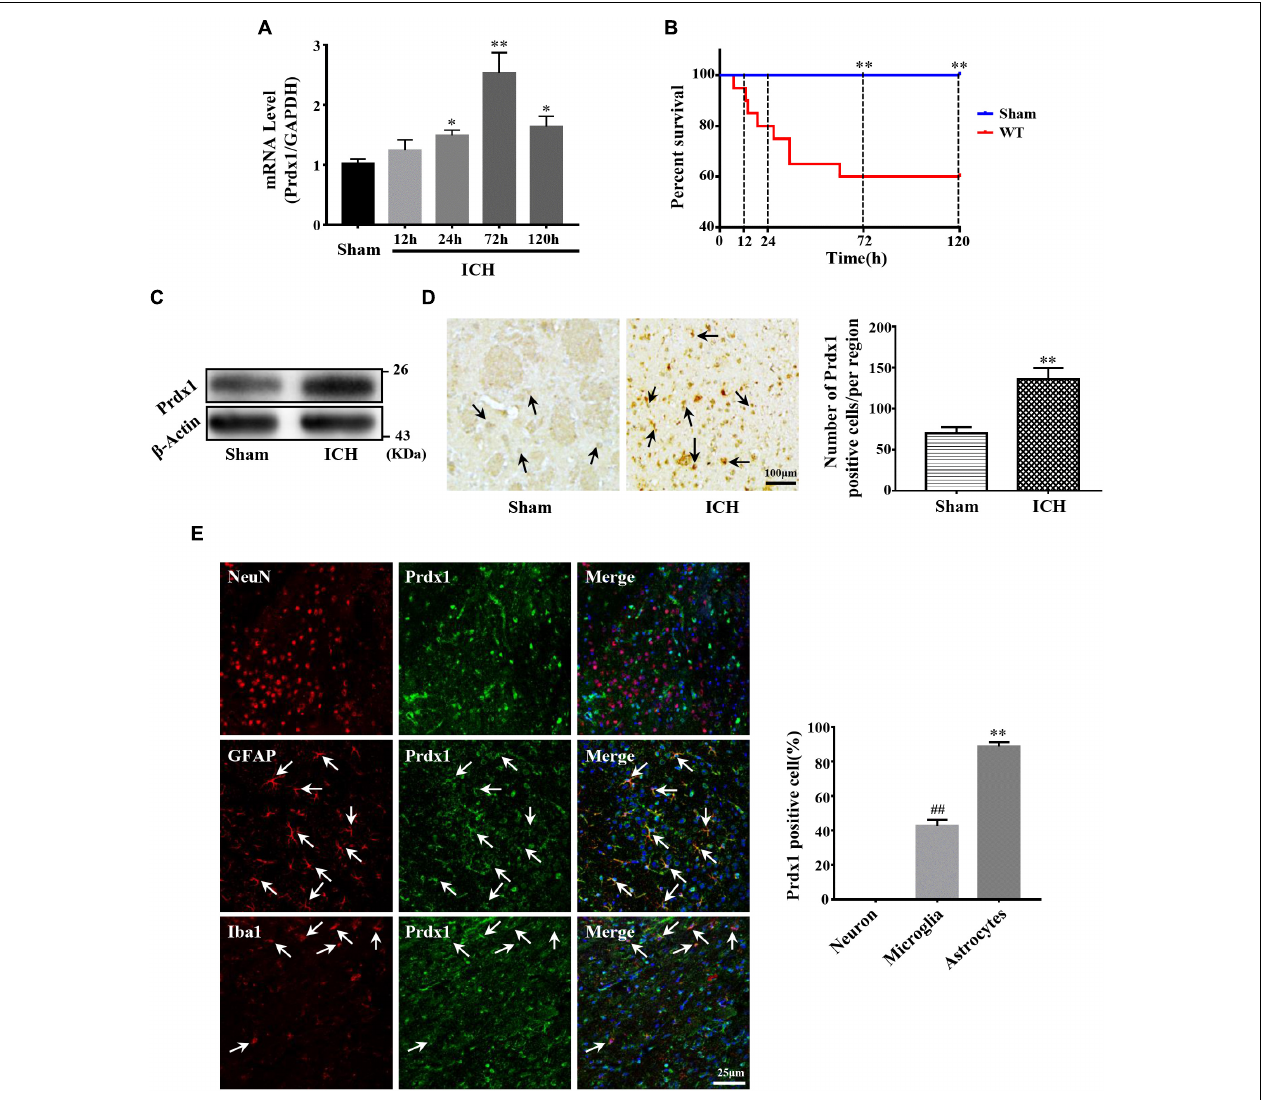
FIGURE 2 | Prdx1 expression was significantly increased in rats after ICH. (A) Prdx1 expression in the perihematomal area was detected by qRT-PCR (df = 4, F = 35.945, ∗ P < 0.05 versus sham, ∗∗ P < 0.01 versus sham, n = 3). (B) Survival statistics of the sham group and WT group ( χ 2 = 10.457, df = 1, ∗∗ P = 0.01, n = 20). (C) Prdx1 expression in the perihematomal area was detected by western blot analysis ( F = 2.014, t = –3.432, ∗∗ P < 0.01 versus sham, n = 3). (D) Prdx1 expression in perihematomal tissue was detected by immunohistochemistry (scale bars, 100 µ m, F = 1.225, t = –7.288, ∗∗ P < 0.01 versus sham, n = 3). (E)